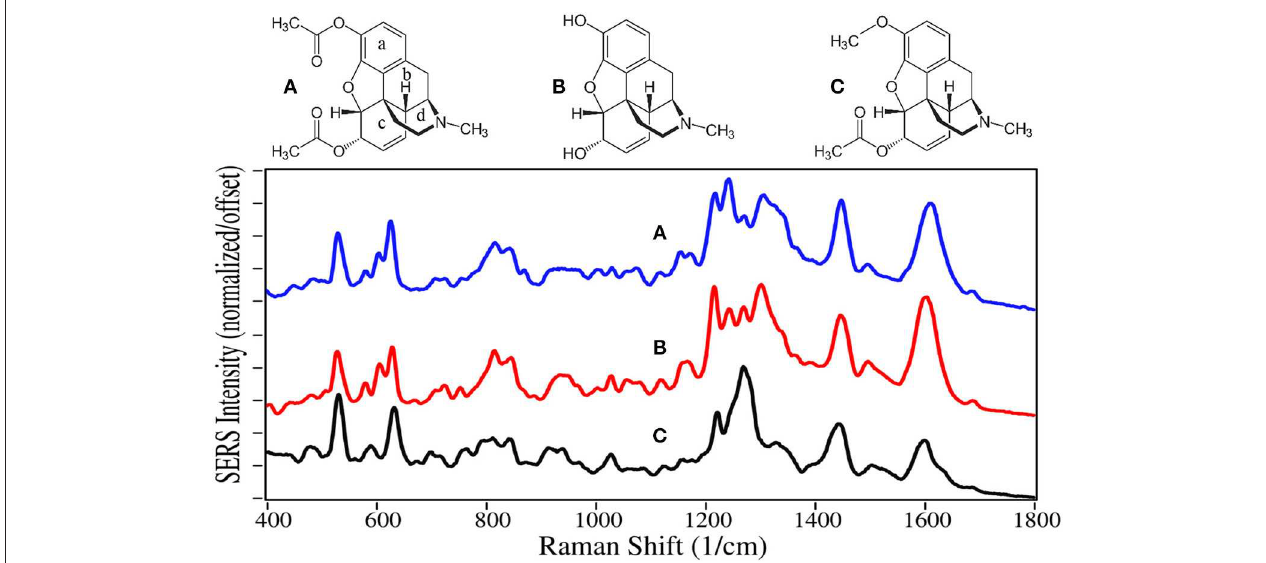
FIGURE 1 | Structures and 10 ppm SERS of (A) heroin, (B) morphine, and (C) 6-acetylcodeine.